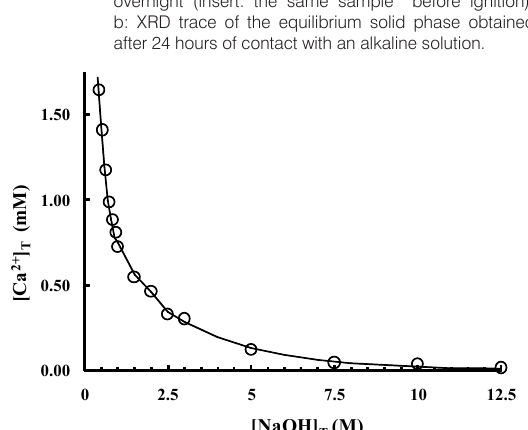
Figure 2. The equilibrium concentration of Ca 2+ , [Ca 2+ ] a function of the total concentration of NaOH, [NaOH] in an aqueous solution saturated with solid Ca(OH) 25.00 ± 0.02 o C. ○ : present work. ♦ : [3]; ----: